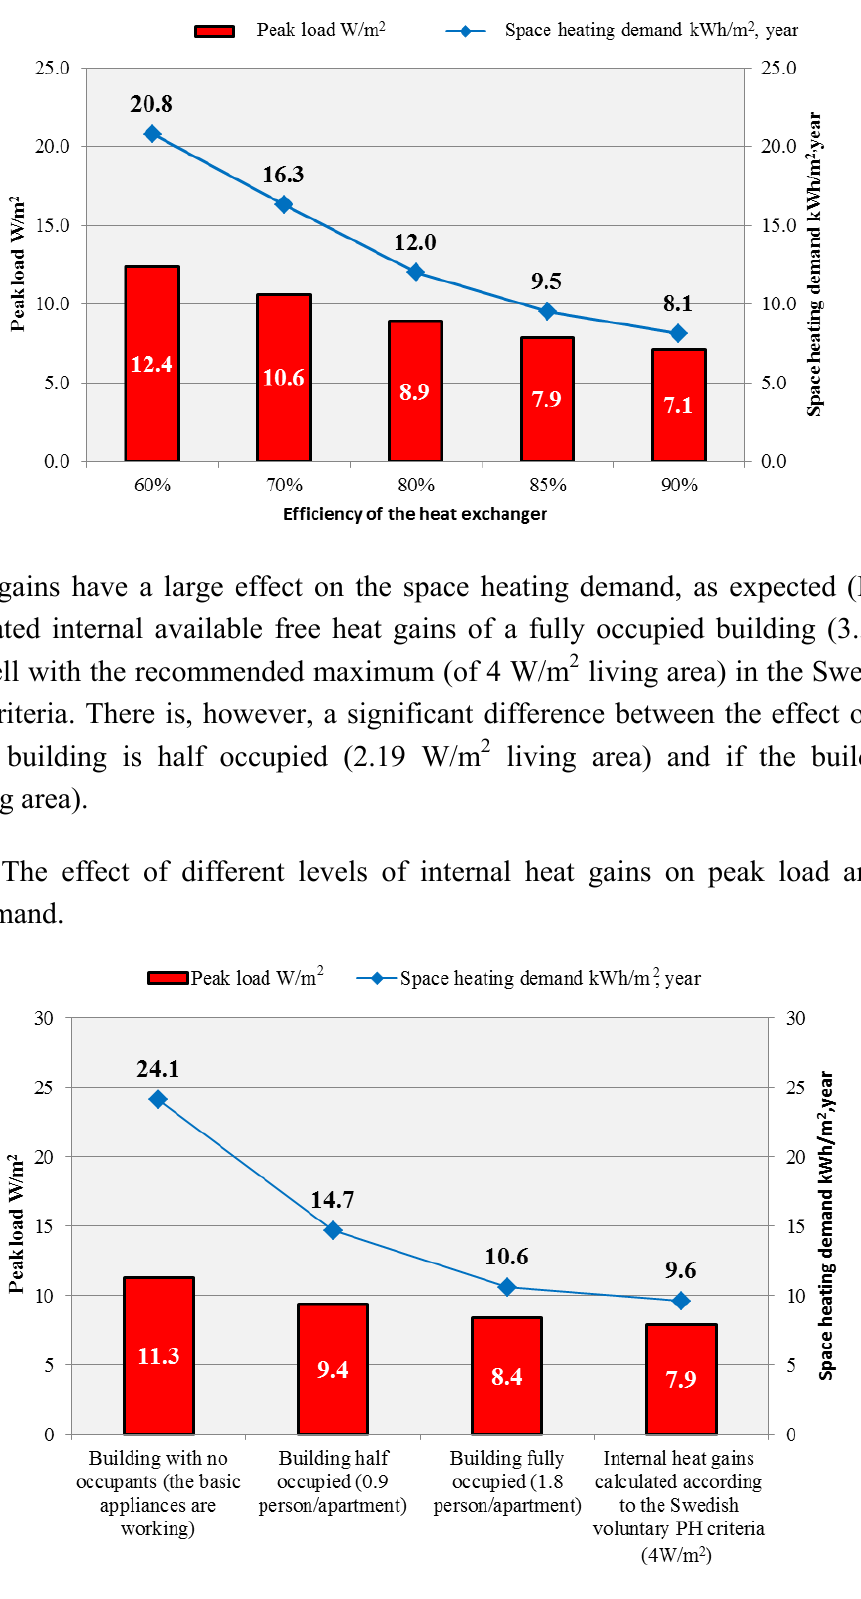
Figure 4. Peak load and space heating demand depending on the efficiencies of the heat exchanger.